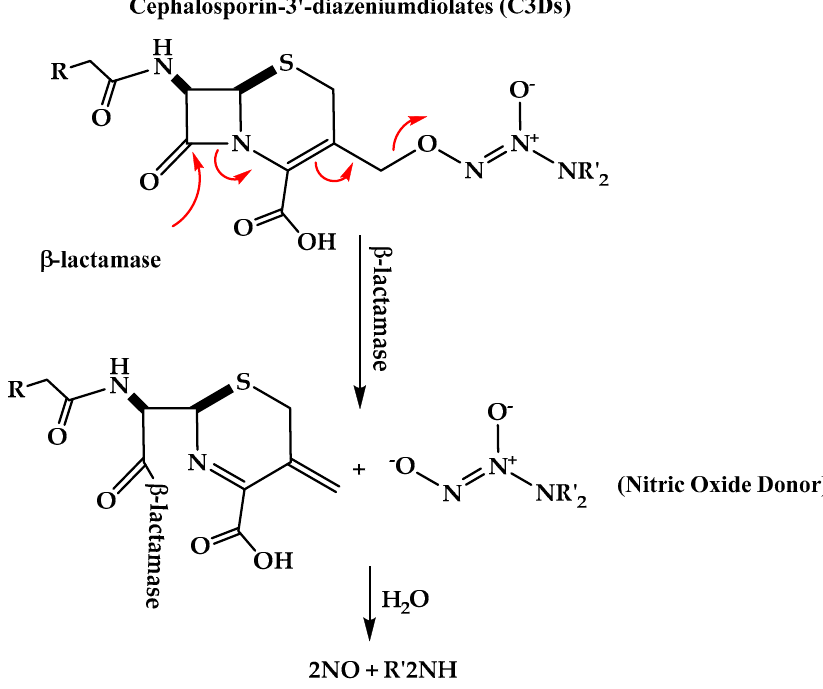
Figure 5. Mechanism of action of the nitric oxide donor prodrug cephalosporin-3 ′ -diazeniumdiolates (C3Ds).